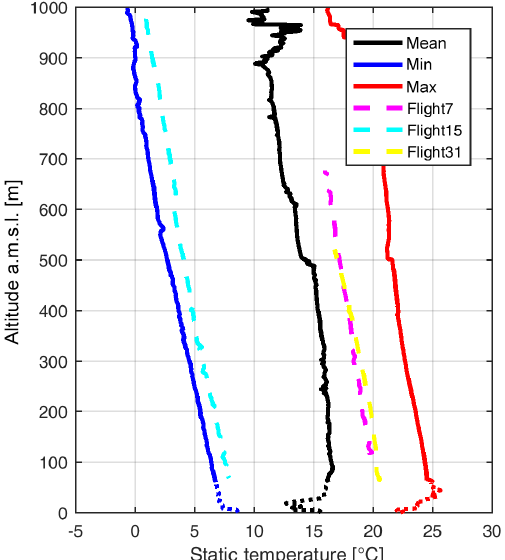
Figure 6. Average temperature profile (black) and range of tem- peratures (minimum: blue; maximum: red) encountered during the 41 WIPAFF measurement flights. Additionally, the averaged pro- files of flight 7 (magenta), flight 15 (cyan) and flight 31 (yellow) are included. As altitudes below 60m altitude were only performed during take-off and landing, i.e. above land and not above the North Sea, the profiles are provided as dotted lines.